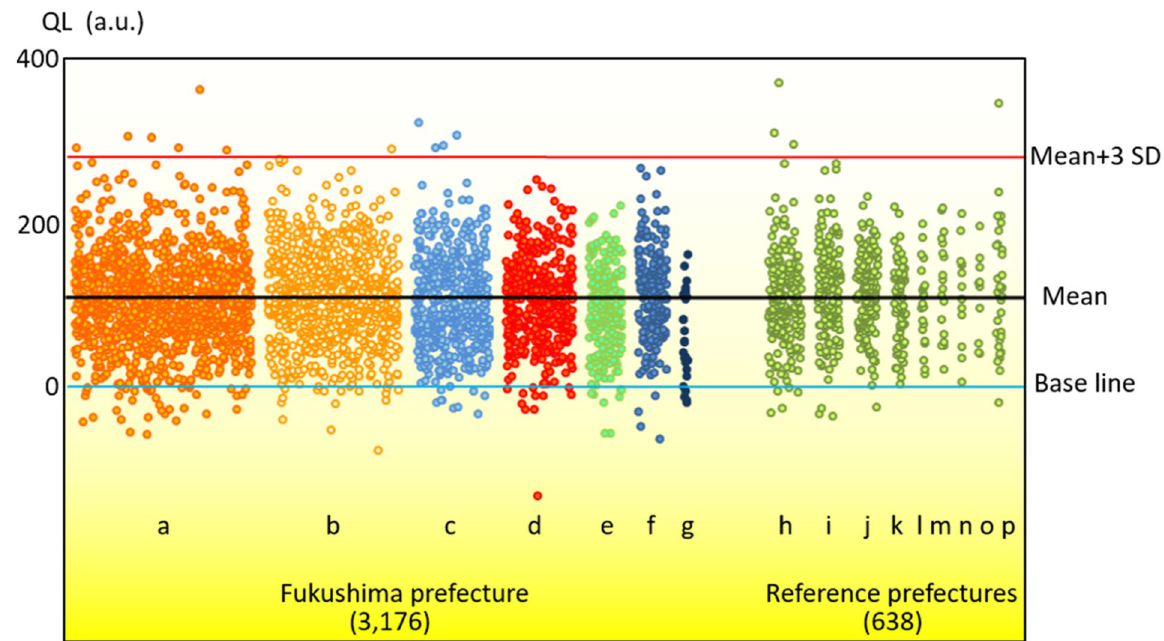
Figure 3. Quantum levels (QL) of deciduous teeth collected from seven districts in Fukushima and those from reference prefectures. The black line shows the mean QL, the red line shows the mean QL + 3 standard deviations (SDs), and the blue line shows the base line. The numbers of teeth are shown in parentheses. ( a ) Ken- poku, ( b ) Ken-chu, ( c ) Iwaki, ( d ) Sou-sou, ( e ) Ken-nan, ( f ) Aizu, ( g ) Minami-Aizu, ( h ) Niigata, ( i ) Shizuoka, ( j ) Hokkaido, ( k ) Kumamoto, ( l ) Miyagi, ( m ) Tokyo, ( n ) Okinawa, ( o ) Kanagawa, ( p ) others. a.u.: arbitrary